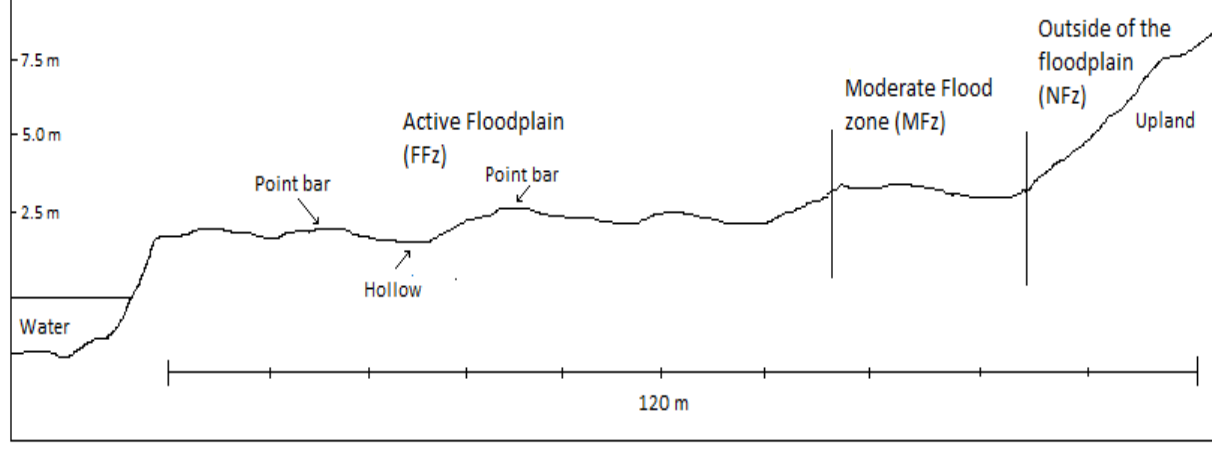
Figure 3. Topographic profile showing the different flood zones (FFz and MFz) and zones outside the floodplain along a longitudinal gradient (perpendicular to the bank). Floodplains are relatively flat with a succession of mounds and troughs due to erosion and